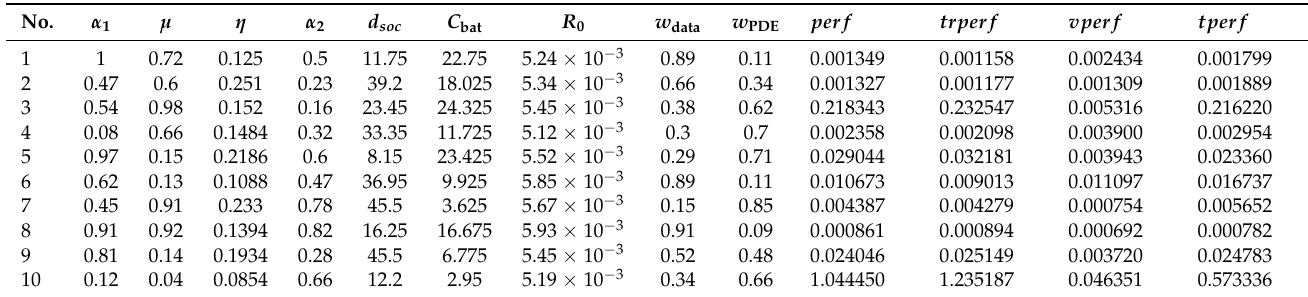
Table 5. Ten groups of radom values of the nine parameters in the three categories for correlation analysis.